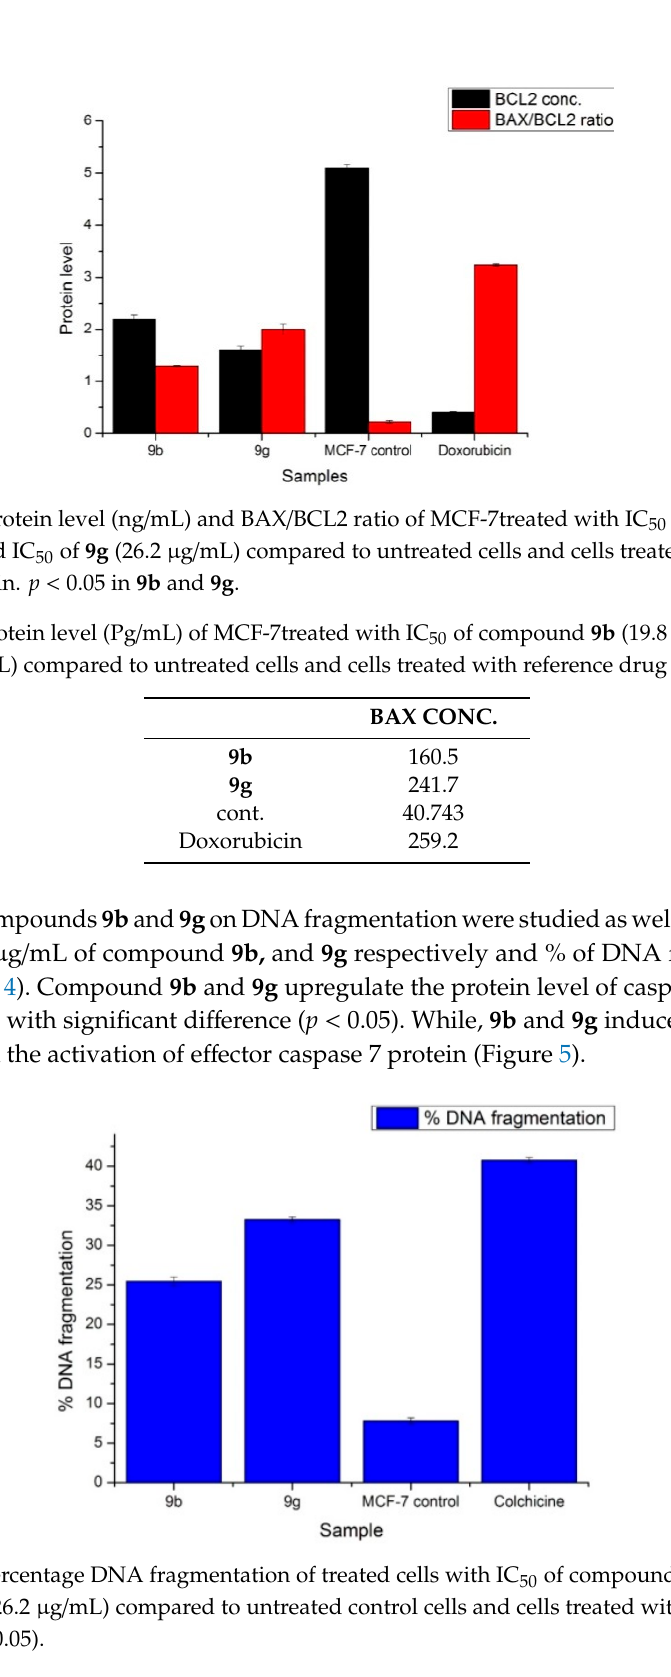
Figure 5. Casp7 (ng/mL) quantitative estimation of MCF-7 treated with IC 50 of compound 9b (19.8 µg/mL) and IC 50 of 9g (26.2 µg/mL) compared to untreated cells and cells treated with reference to the drug Doxorubicin ( p < 0.05). 2.3. Microspheres Encapsulation Compounds 9b and 9g were chosen as examples to be encapsulated in Na-alginate microspheres, the samples were encoded after encapsulation as M9b, and M9g , respectively and the blank microspheres encoded as B . 2.4. Morphology and Size of Microspheres The morphology and diameter of prepared microspheres were determined from SEM micrographs (Figure 6). As shown in the Figure 6, the microspheres were spherical with rough surfaces. Moreover, the mean diameter values of microspheres, measured from SEM micrographs, were 38 µm, 24 µm, and 47 µm for B , M9b, and M9g samples, respectively. As a consequence, M9b microspheres showed the smallest diameters, while M9g microspheres demonstrated the biggest ones. This can be attributed to the chemical composition of the encapsulated heterocyclic compounds. The chemical structure of 9b contained the Cl atom, which is highly electronegative. As